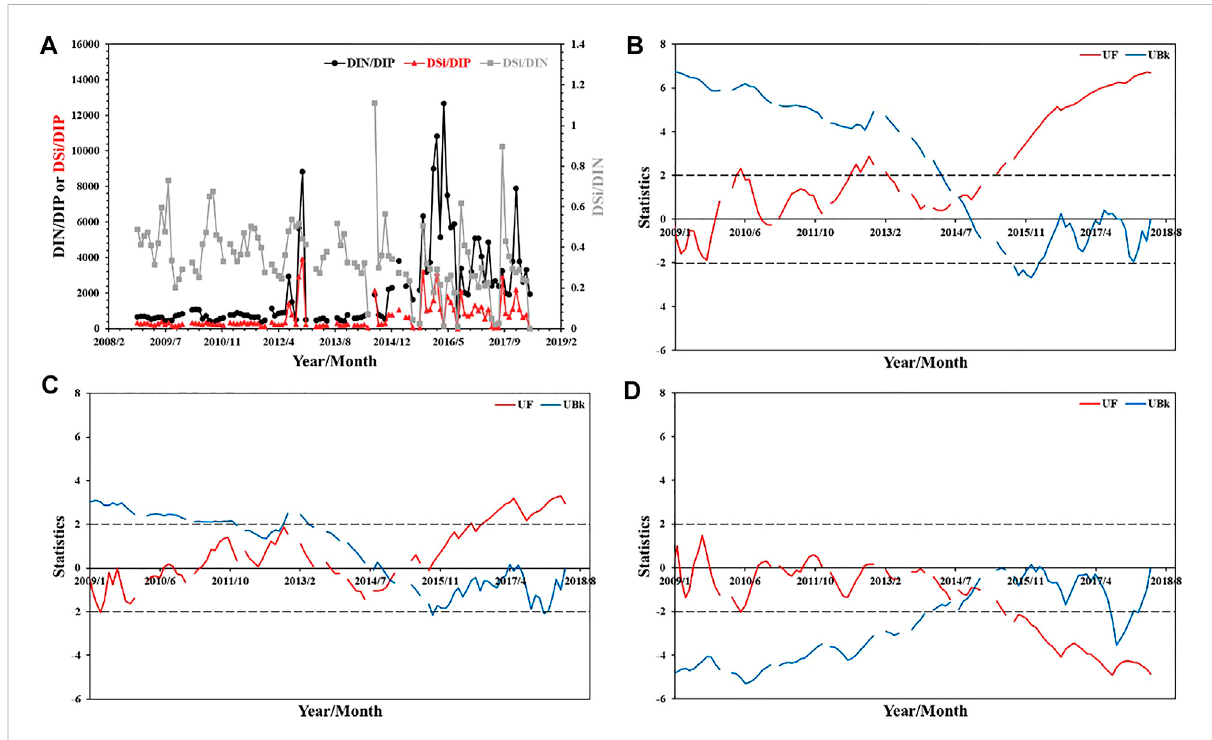
FIGURE 6 (A) TemporalvariationsinthedissolvednutrientratiosatLJfrom2009to2018.Mann-Kendalltestsfor (B) DIN/DIP, (C) DSi/DIPand (D) DSi/DIN. The dotted lines in (B) – (D) represent the signi fi cant level of 0.05.